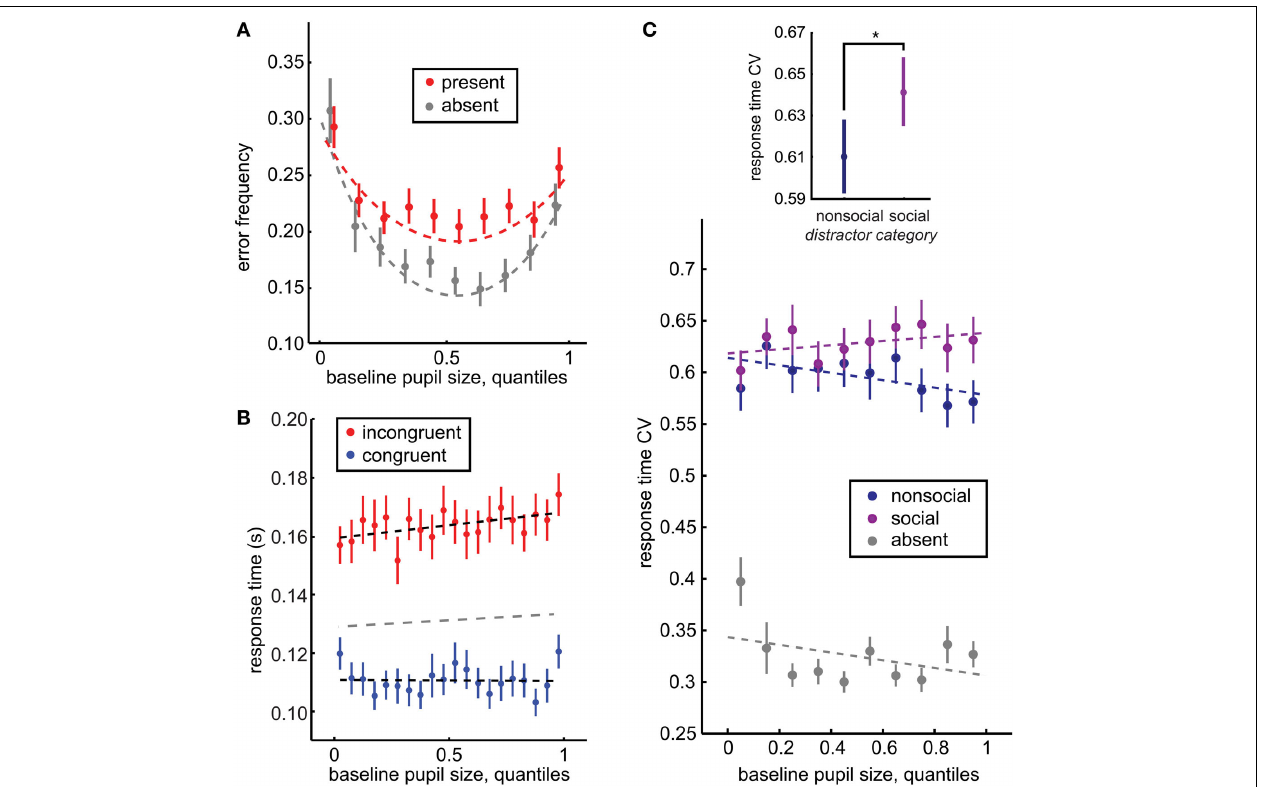
response time is a measure of the dispersion of the response time distributions across the incongruent and congruent locations. Inset: Response time CV was larger following social distractors than non-social distractors, bars reflect ± standard deviation. Main figure: Response time CV is specifically enhanced for social distractors as baseline pupil size increases ( p < 0 . 02, β 5 = 0 . 059), suggesting that the increasing variance in response time with increasing baseline pupil size is driven by the social distractors. Bars ± s.e.m. across sessions. Dotted lines reflect GLM model fits to binned data (30 quantile bins; for clarity of visualization, a smaller number of bins is plotted in each panel). ∗ p < 0 . 02 , z = 2 . (71)